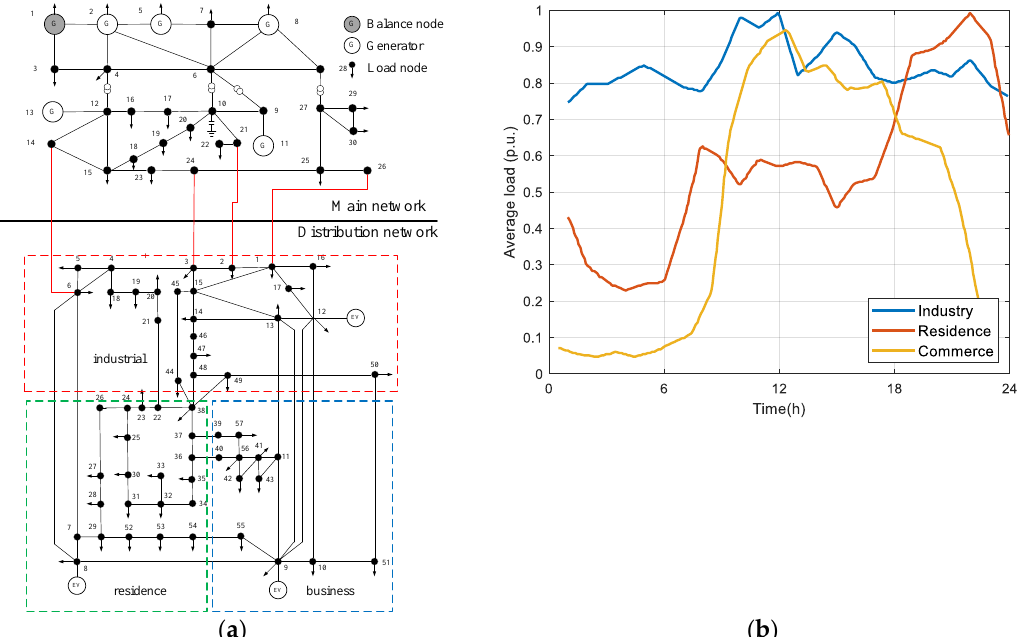
Figure 6. Example diagram and load data: ( a ) diagram of calculation example; ( b ) typical load curve of each area. Table 1. The 57-node calculation case partition (20 kV). Region Node